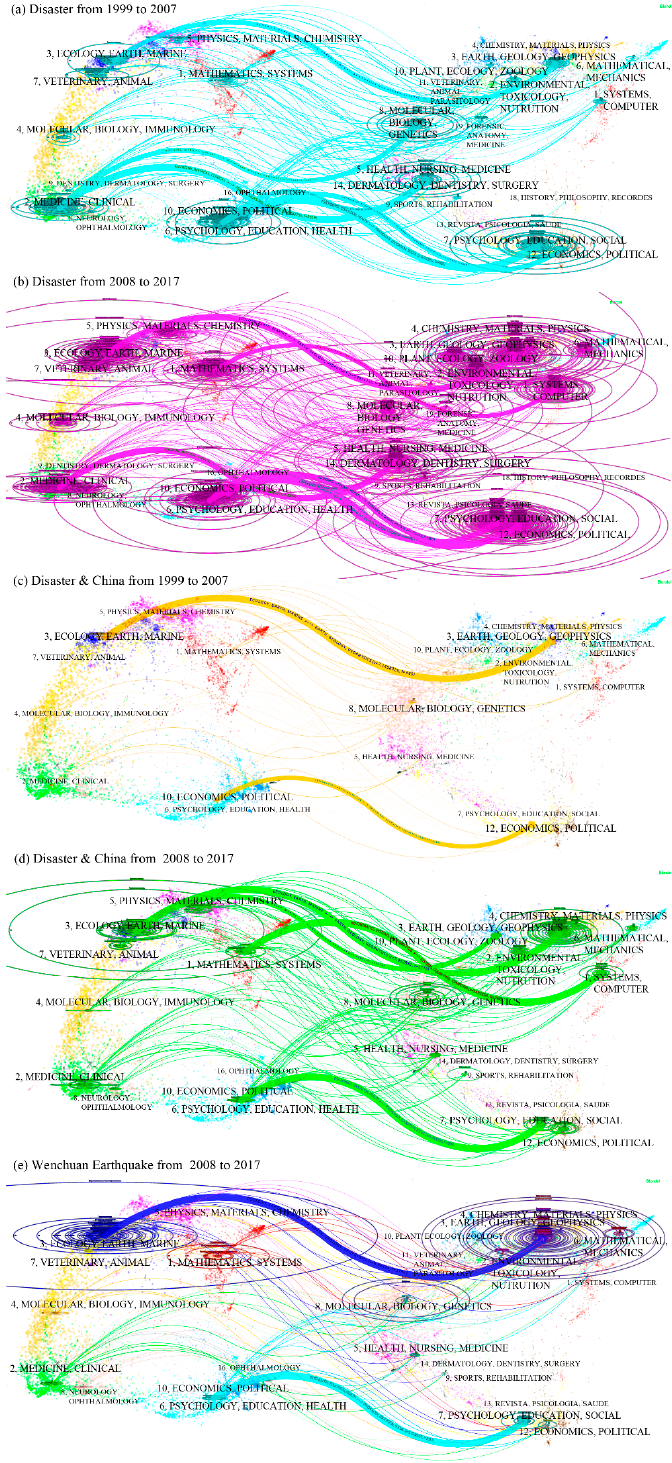
Figure 7. Study activities for the “Disaster” topic with cross-disciplines over the past 20 years. The left side and right side are the citing journals and the cited journals, respectively; each dot is a journal, and the line provides a function of the link that connects the citing journal and the cited journal. The longitudinal axis of the ellipse represents the numbers of articles published in one journal, and the horizontal axis of the ellipse represents the corresponding author number. Each label represents a discipline. Refer to Chen and Leydesdorff [19] for the detailed theories and techniques. With these data, citing behaviours can be clearly